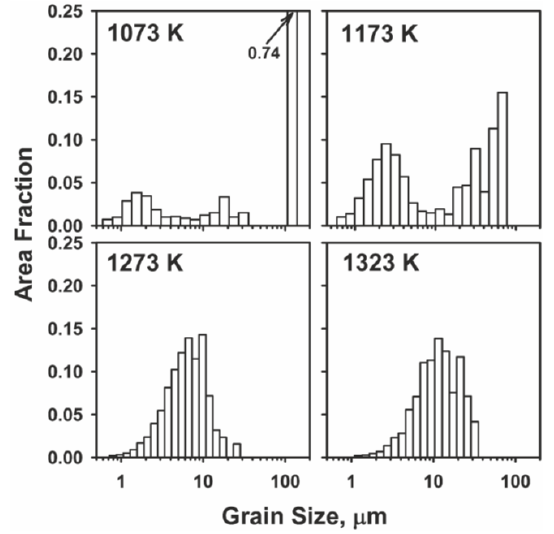
Figure 3. Grain size distributions that evolved in the high-nitrogen austenitic stainless steel during compression to a strain of 1.2 at the indicated temperatures and a strain rate of 10 −3 s −1 .